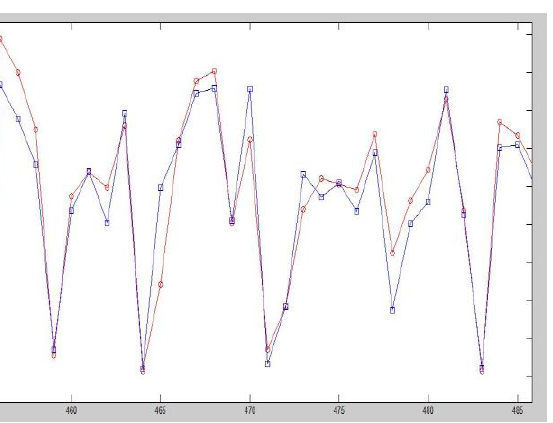
Figure 10. Results of the neural network for the test data If the output of the network and the corresponding observed are closed, the network training is acceptable. In other words, if we have a plot with training data on X axis and output of neural network for training data on Y axis, the results are near to diagram y=x, as shown in figure 11. This is true for test data as well, as shown in figure 12.